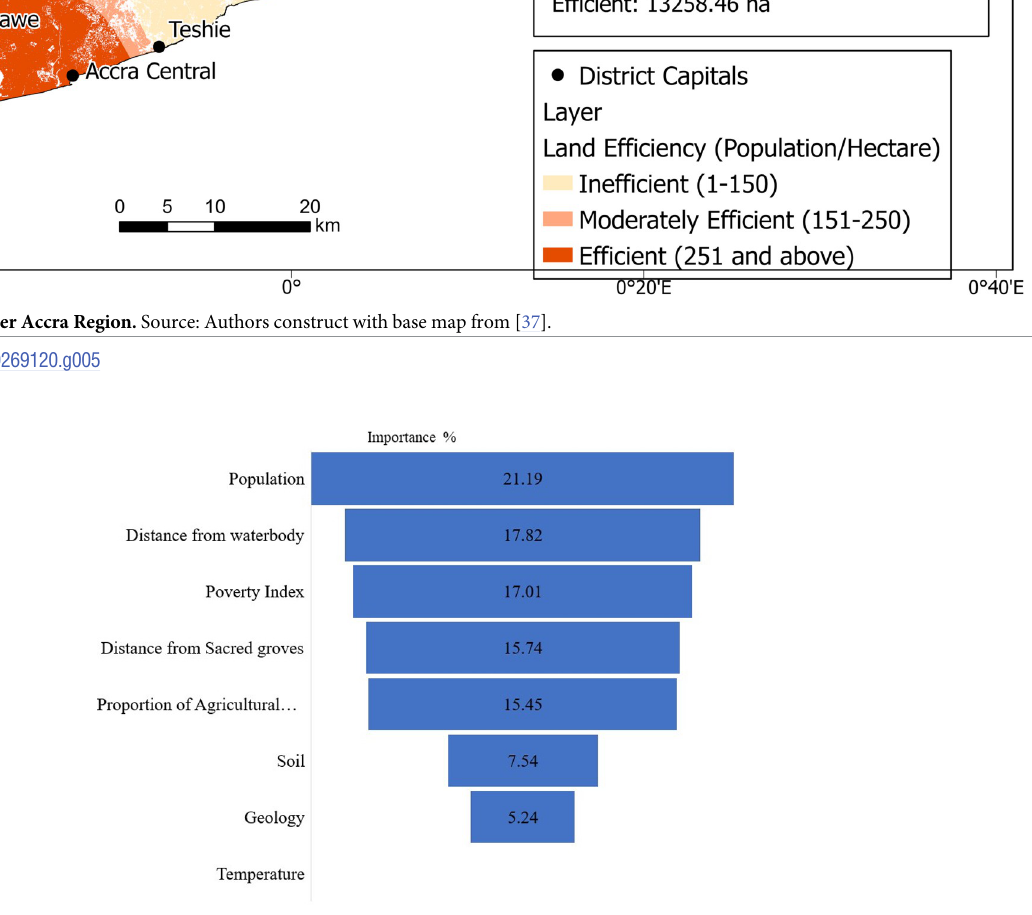
PLOS ONE | https://doi.org/10.1371/journal.pone.0269120 June 7,